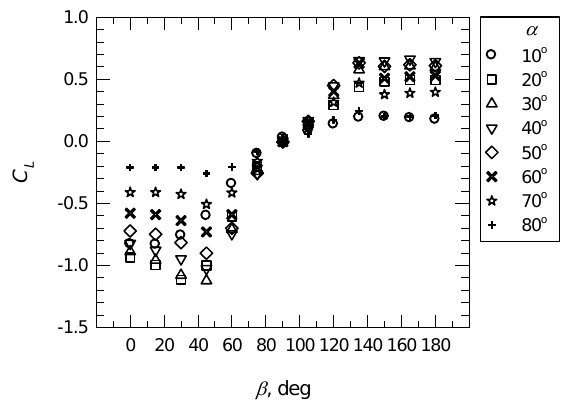
Figure 12. Lift coe ffi cient. α : 0 ◦ –80 ◦ . Figure 12. Lift coefficient. α : 0°  80°.